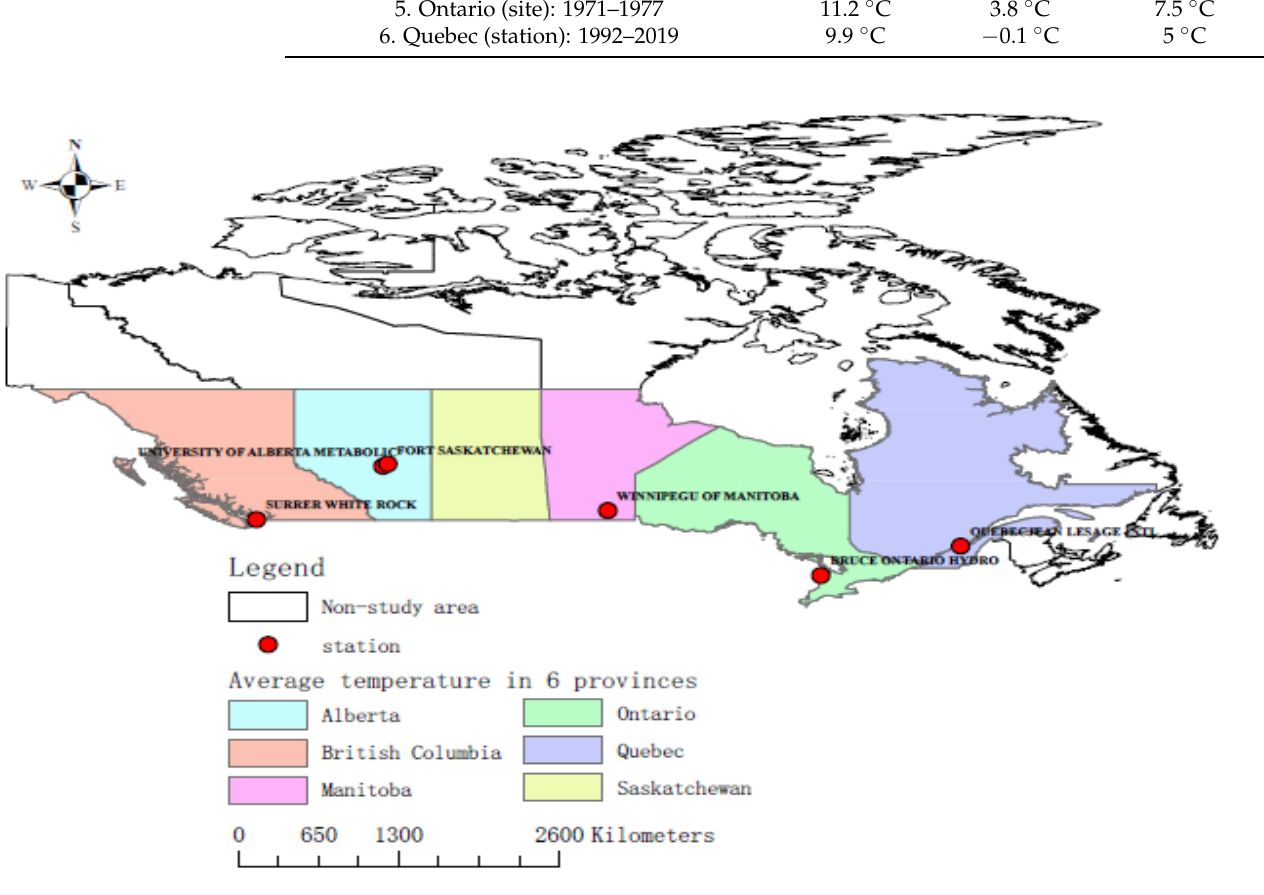
Figure 2. Observation sites in Canadian provinces.